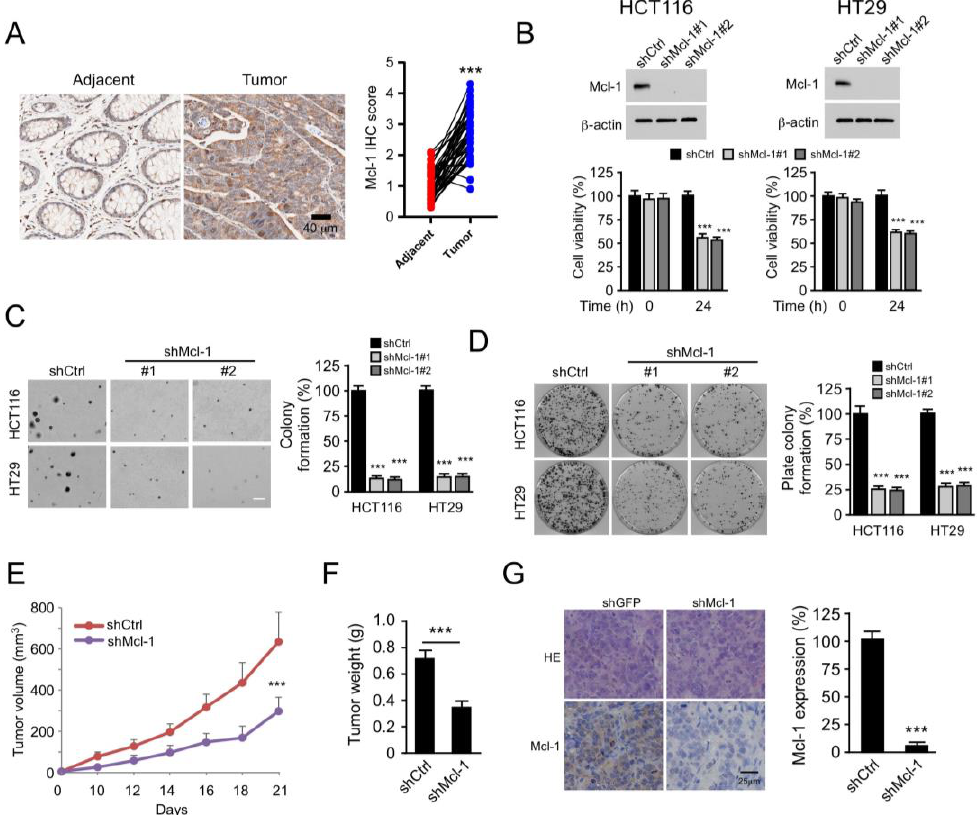
Figure 5. Knockdown of Mcl-1 expression suppresses tumorigenesis of CRC cells. ( A ) IHC analysis of Mcl-1 staining in 43 CRC tissues and adjacent non-tumor tissues. Representative images of Mcl-1 IHC staining are shown on the left. The identification results are shown on the right. Scale bar, 40 µ m. ( B ) Cell viability of HCT116 (left) and HT29 (right) cells expressing shCtrl or shMcl-1. Top, IB analysis of Mcl-1 expression. Bottom, cell viability as determined by MTS analysis. Data are represented as mean ± SD (n = 3). *** p < 0.001. ( C ) The soft agar assay analysis of the colony formation assay corresponding to HCT116 and HT29 cells transfected with shCtrl or shMcl-1. Data are represented as mean ± SD (n = 3). Scale bar, 200 µ m. ( D ) Colony formation of HCT116 and HT29 cells in plates transfected with shCtrl or shMcl-1. Data are represented as mean ± SD (n = 3). *** p < 0.001. ( E – G ) Tumor development of shCtrl- or shMcl-1-transfected HCT116 cells in vivo. Measurement of tumor volume ( E ), weight ( F ), and Mcl-1 IHC staining ( G ). E-F, n = 5 (5 mice), ( G ) data are repre- sented as mean ± SD (n = 6); 2 tissue slides per tumor. *** p < 0.001. Scale bar, 25 μm. IHC, immuno- histochemical; Mcl-1, myeloid leukemia 1, CRC, colorectal cancer; sh, short hairpin RNA; MTS, (3- (4,5-dimethylthiazol-2-yl)-5-(3-carboxymethoxyphenyl)-2-(4-sulfophenyl)-2H-tetrazolium; IB, im- munoblotting.